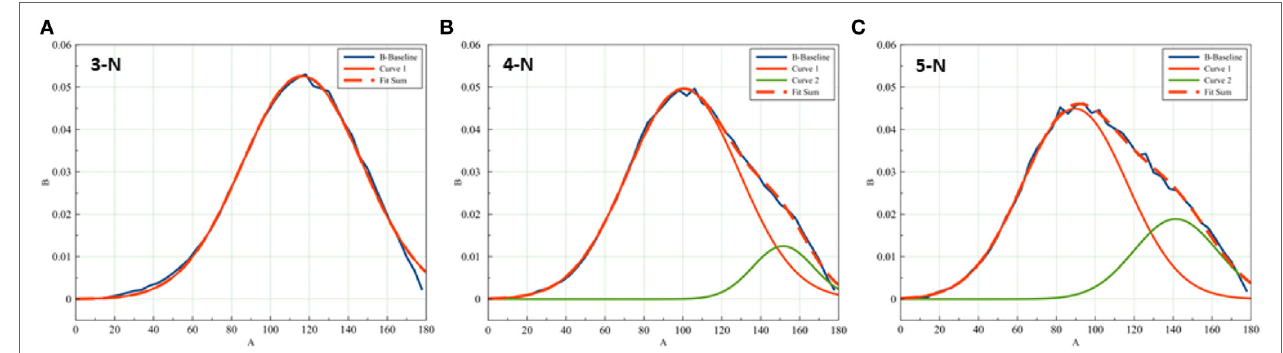
FigUre 11 | Skewness of the ITA distribution increases with node connectedness. While (a) 3-N distribution can be fitted with a single Gaussian distribution, the distributions of (B) 4-N and (c) 5°-N ITA values require a minor Gaussian curve for a good fit. The minor distributions center around